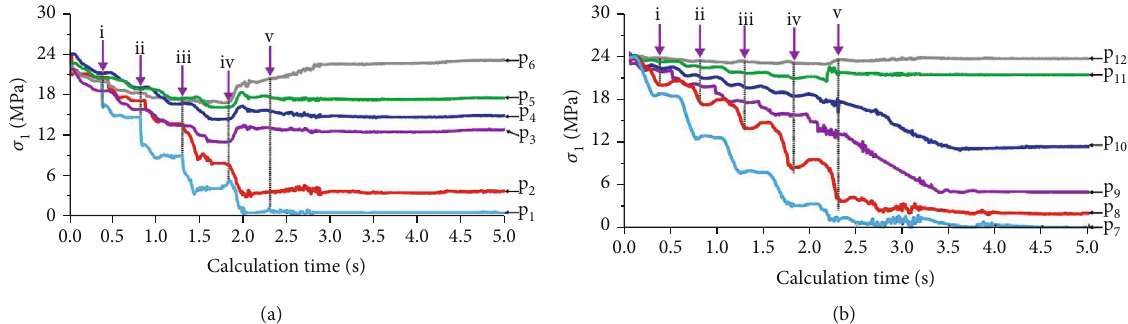
Figure 12: Variation law of maximum principal stress at each measuring point with the calculation time step: (a) region I; (b) region